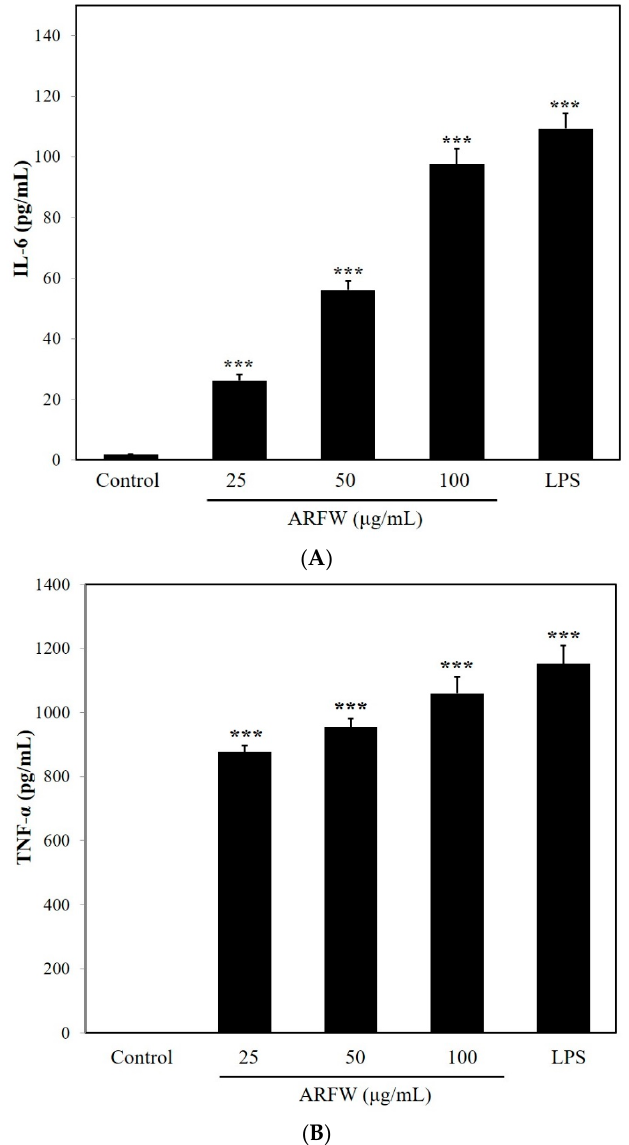
Figure 2. ARFW increased the release of cytokines (IL-6 ( A ); TNF- α ( B )). The production of cytokines was determined by ELISA assay. All values are expressed as the means ± S.D. *** p < 0.001 vs control.